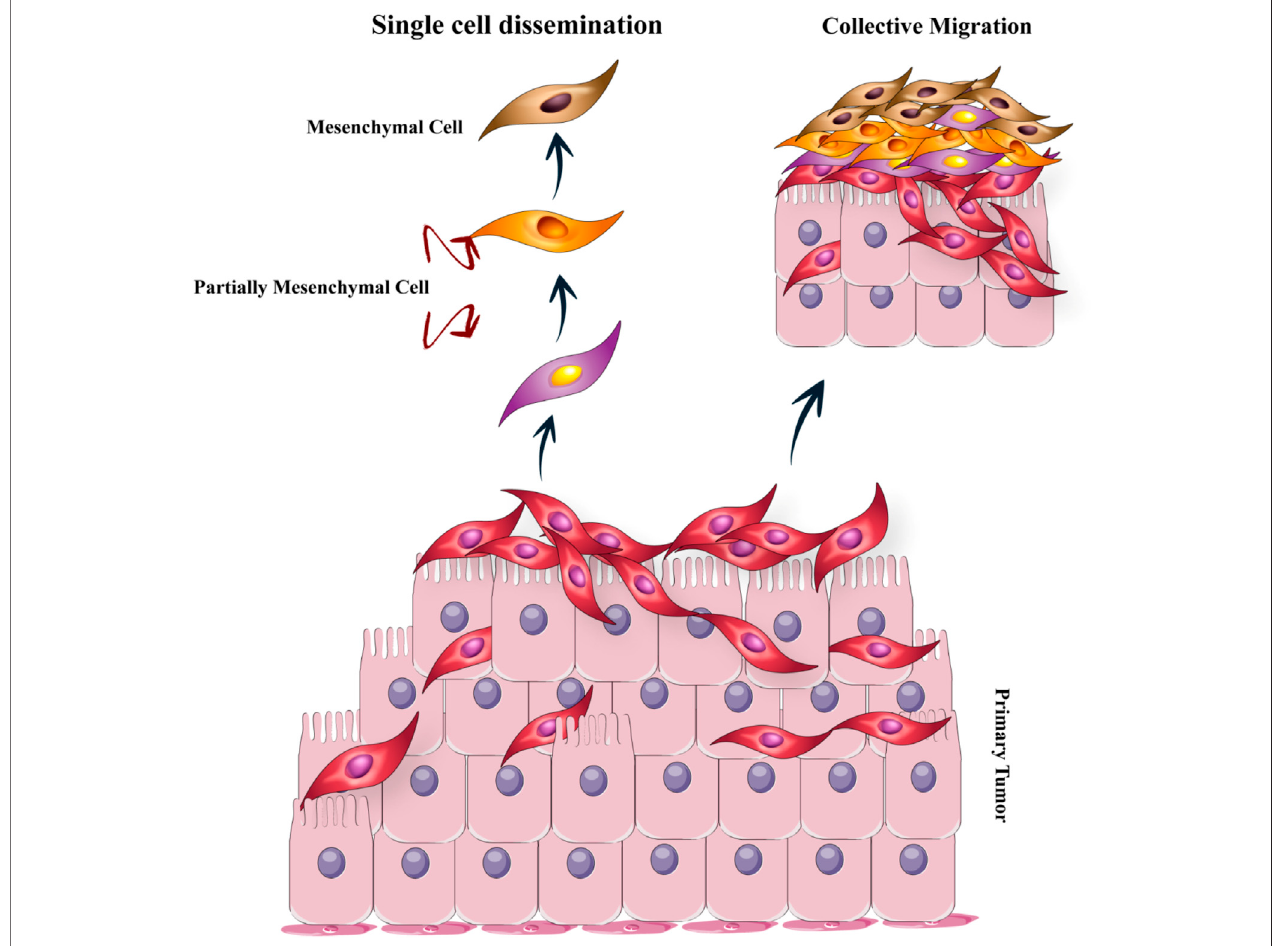
FIGURE3| Theepithelial – mesenchymal transition (EMT):TheEMTprogramisacellstate thatepithelial cellsacquire mesenchymalcell properties and arecapable of migration. There are two main invasion patterns of tumor cells: individual cell dissemination and collective cell migration.